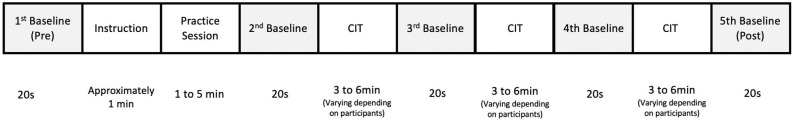
The flow of the experiment.